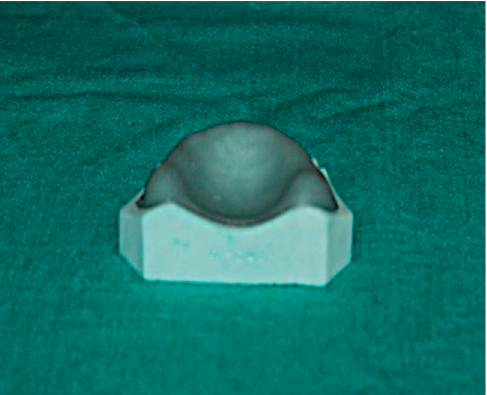
Figure 2. Record Base Fabricated by Conventional Technique (Group-A).